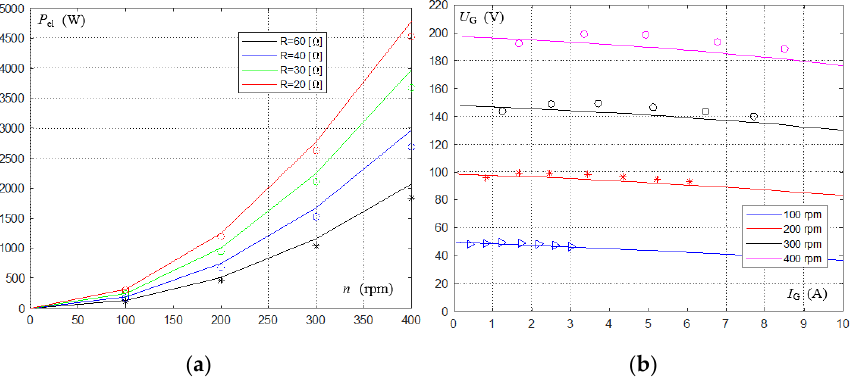
Figure 27. ( a ) Generator G2-power as a function of rotational speed for different resistive loads; ( b ) generator G2-voltage as a function of current for selected rotational speed values; points-measurement results, solid line-analytical calculations.